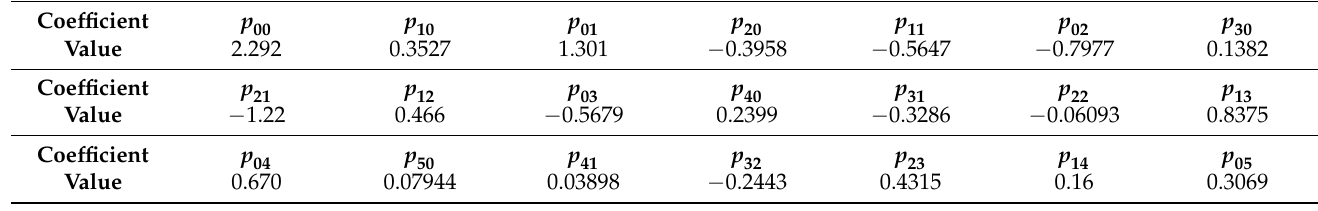
Table 10. The values of the approximated coefficients.